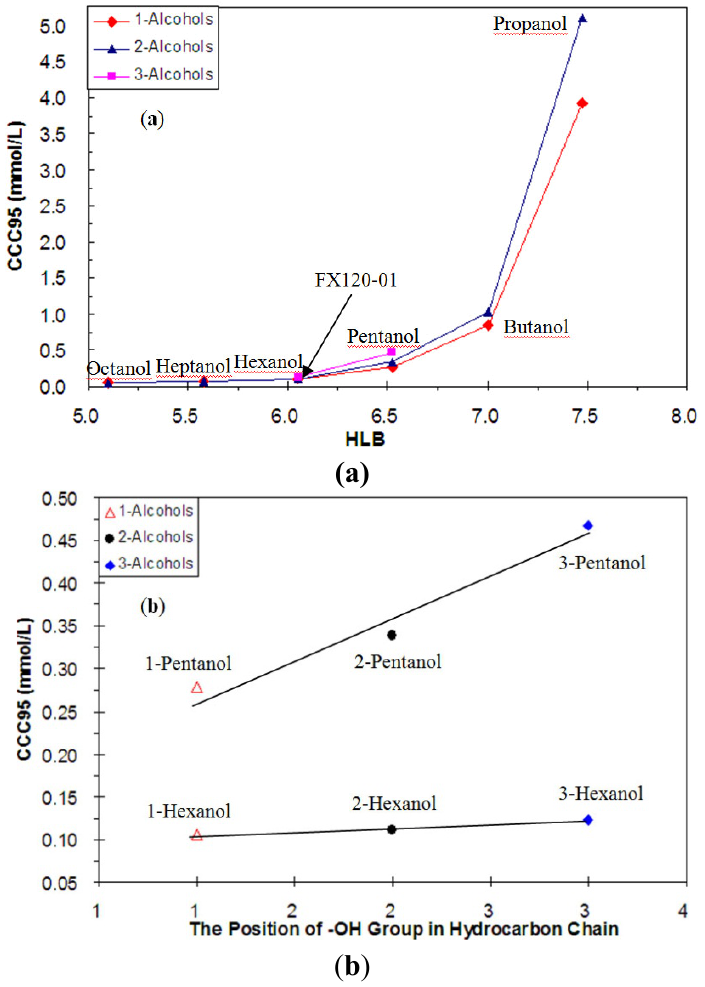
Figure 8. ( a ) CCC95 versus HLB for the Aliphatic Alcohols and their isomers (1-Alcohol, 2-Alcohol and 3-Alcohol); ( b ) the effect of –OH group position on CCC95 for Pentanol and Hexanol isomers.